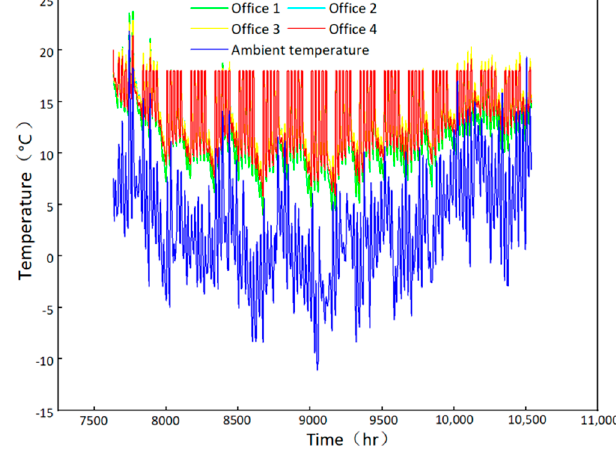
Figure 2. Solar irradiation during the heating season.